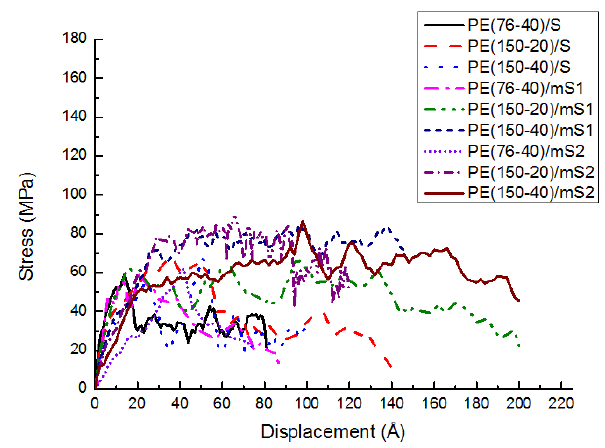
Figure 9. The effect of PE chain length, number and coupling agent on the stress-displacement behavior of PE/S at 300 K.